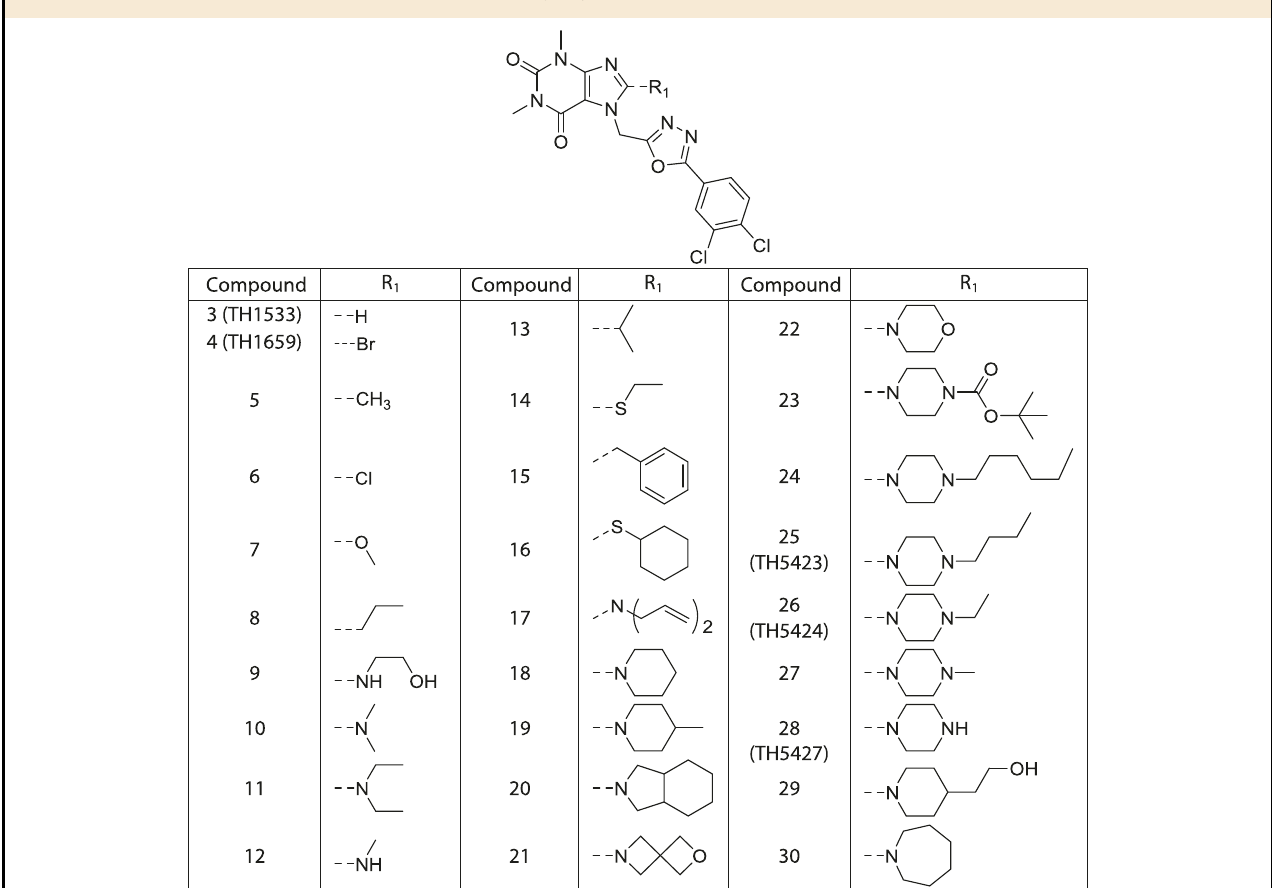
Table 2 Small molecule inhibitors of NUDT5 combining aspects of TH1713 and